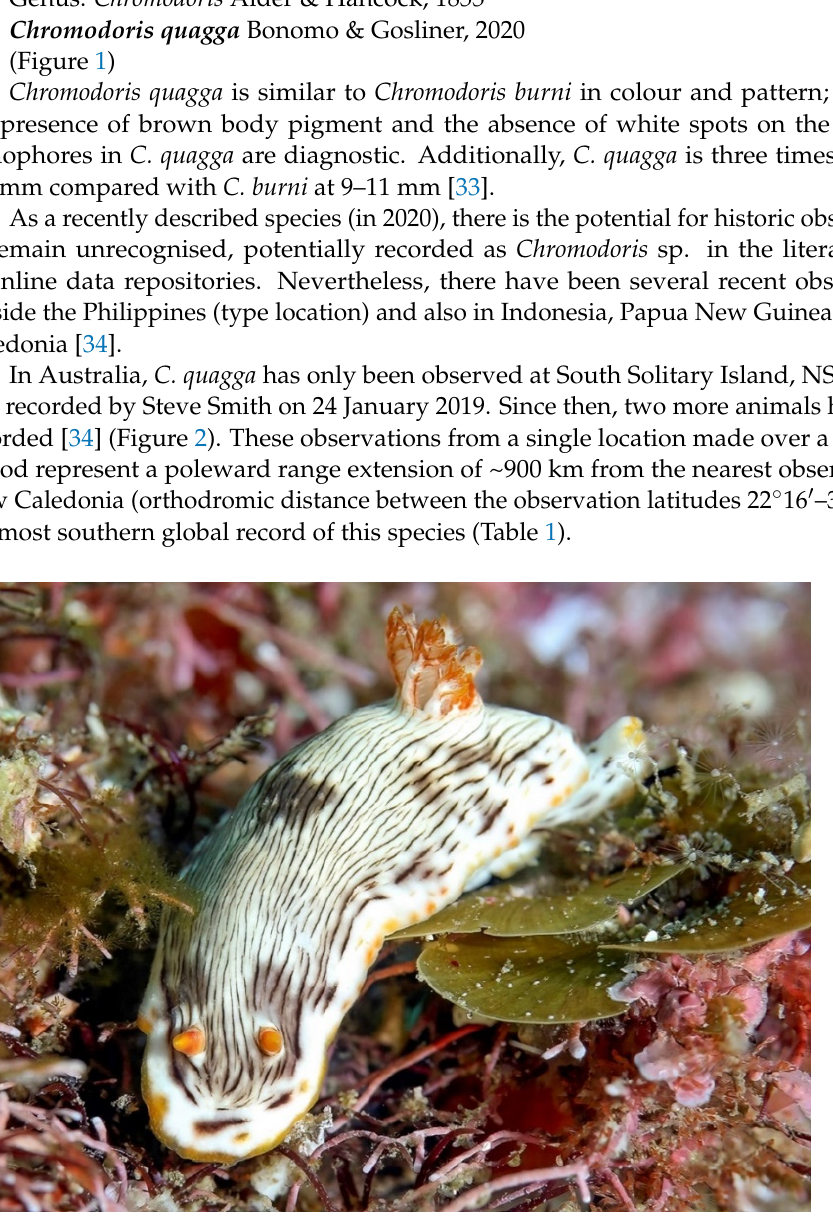
Figure 2. Chromodoris quagga , South Solitary Island, NSW, 29 January 2022. Photo: B. Touzell. Table 1. Distribution records of Chromodoris quagga in Genus: Hypselodoris Stimpson, 1855 Hypselodoris bertschi Gosliner & R. F. Johnson, 1999